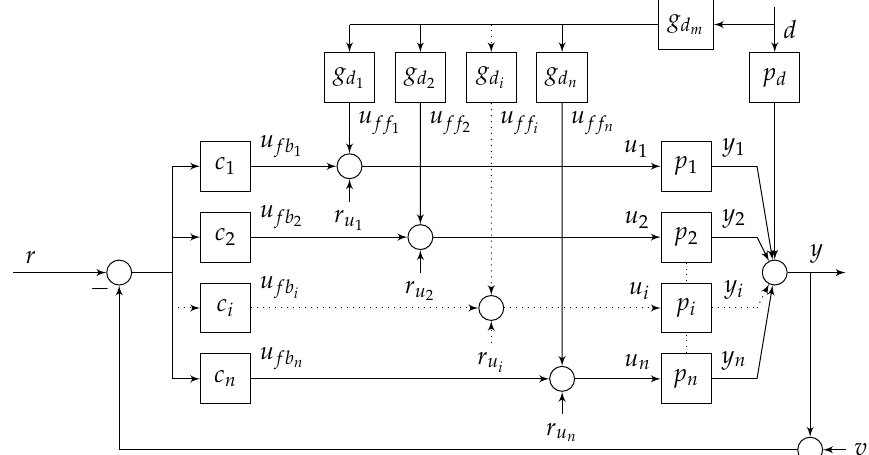
Figure 1. Feedback–feedforward control structure for robust rejection of measurable disturbances in multi-input